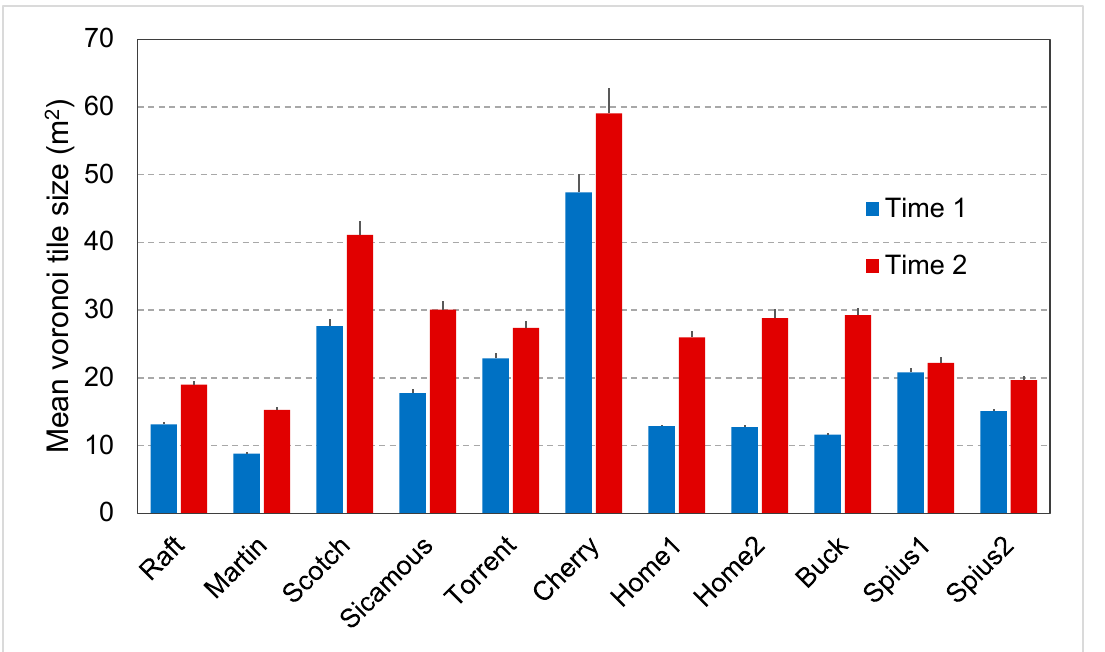
Figure 10. Change in Voronoi tile area (m 2 , mean ± S.E.), as “area potentially available” to individual healthy trees (tree code = 0, all species) for the 11 one-hectare plots. Measured change is from time of plot establishment (Time 1) to most recent assessment (Time 2). The range of years between Times 1 and 2 was 7–15.